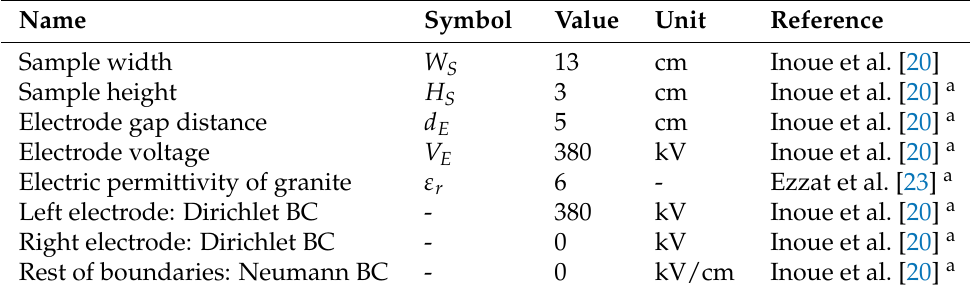
Figure 2. 2D numerical simulation domain. The contour lines represent equal electric potentials. The red boxes should align parallel/perpendicular to the equipotential lines. In the later “pore- scale” analysis, it is assumed that the equipotential lines are parallel/perpendicular to the sample boundaries. Table 1. The parameters and boundary conditions used during the sample-scale